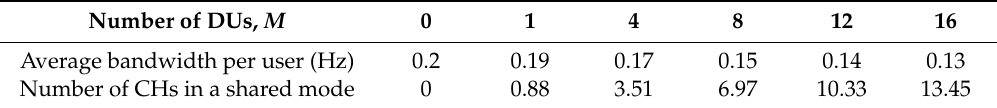
Table 2. Average bandwidth per user with various numbers of DUs, M ( N = 16). Number of DUs,